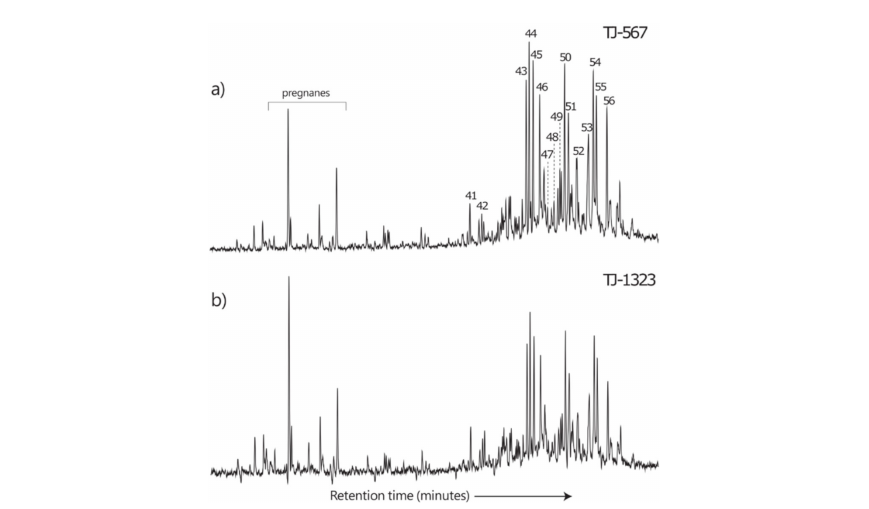
Figure 6. The m / z 217 ion chromatograms of the saturated hydrocarbons of representative TJ-567 ( a ) and TJ-1323 ( b ) oils showing sterane